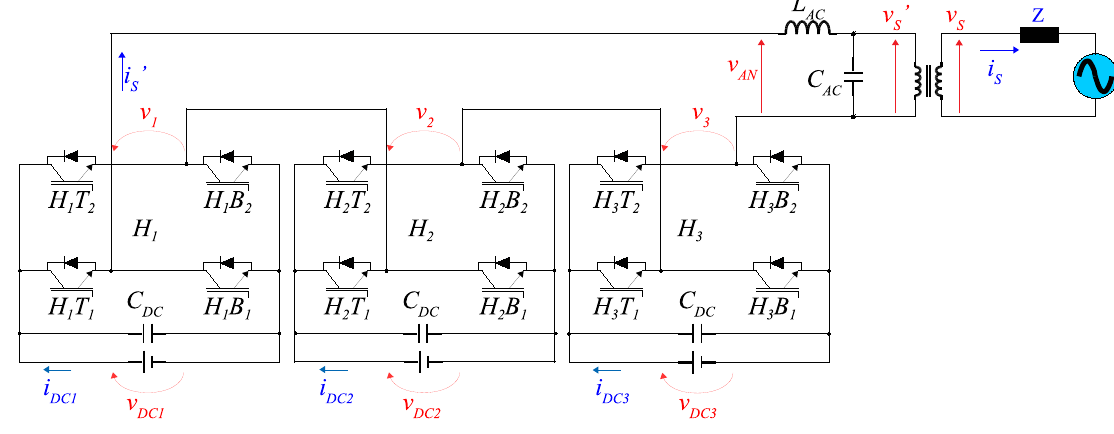
Figure 2. Electrical circuit of the developed